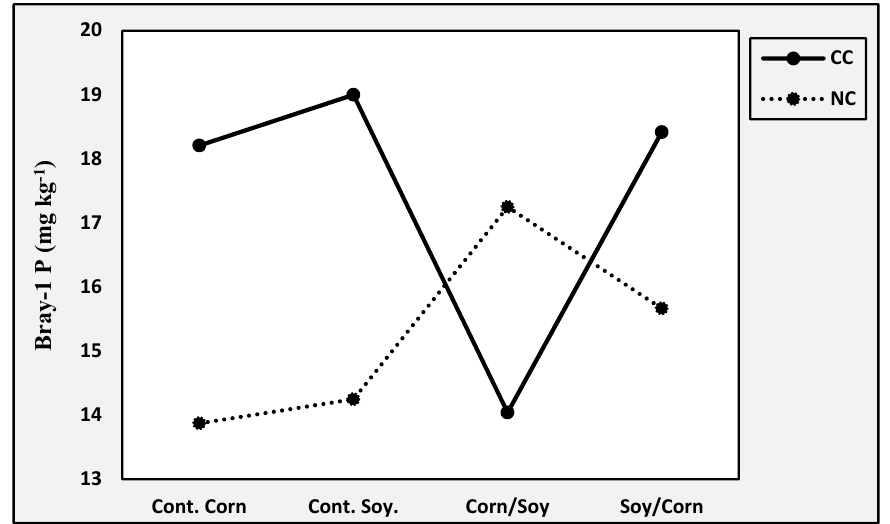
Figure 4. Effects of cover crop x crop rotation on Bray 1 P in 2013. Please note that CC = cover crop; NC = no cover crop.